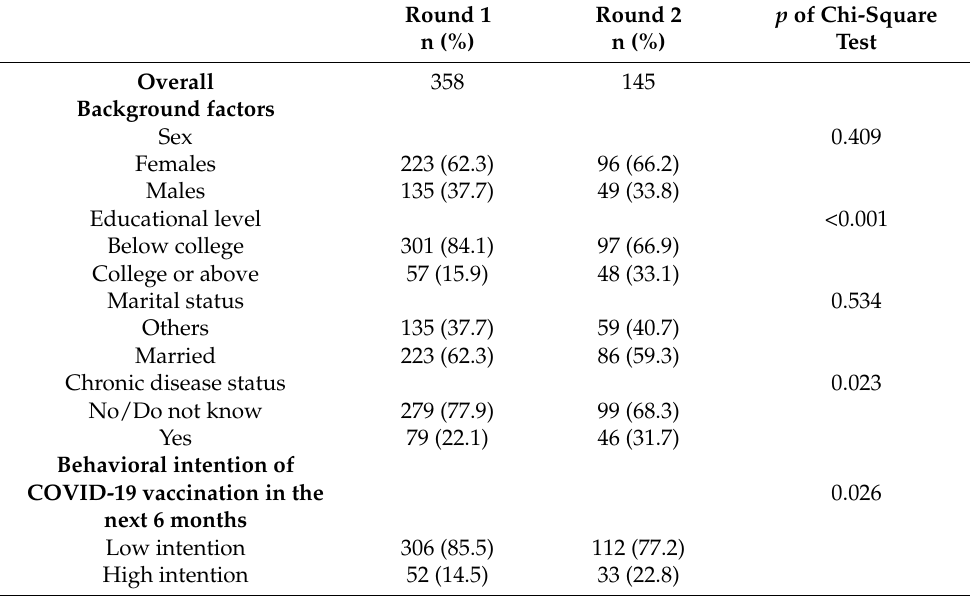
Table 1. Comparisons of the background characteristics of the two